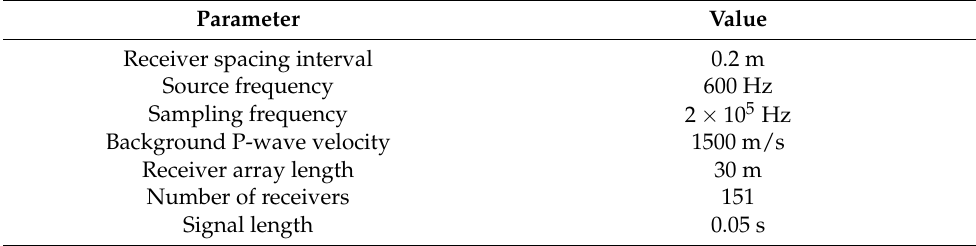
Table 1. Numerical experiment parameters.